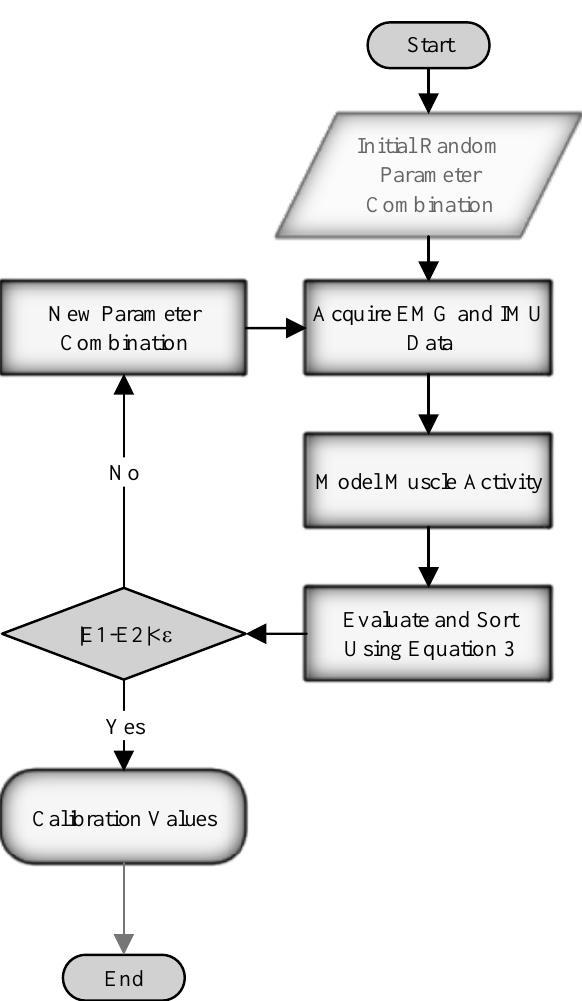
Figure 3. Flowchart of the proposed optimization in the study. E 1 and E 2 represent the smallest modelled muscle activity after they have been sorted and ε represents the user defined stopping criteria.